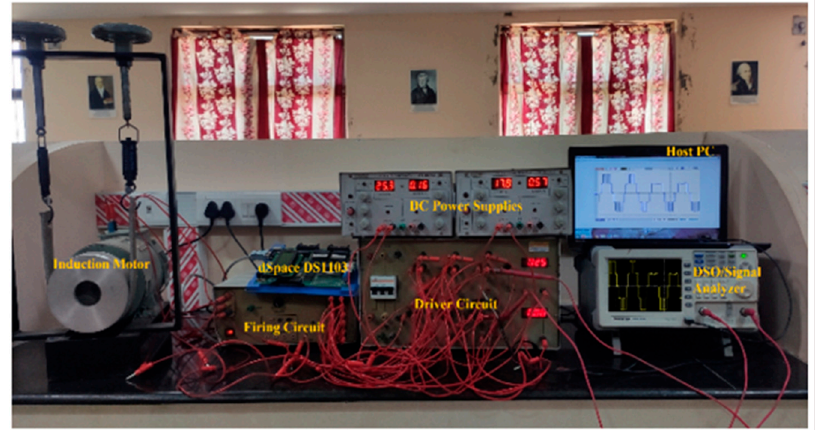
Figure 10. Hardware prototype